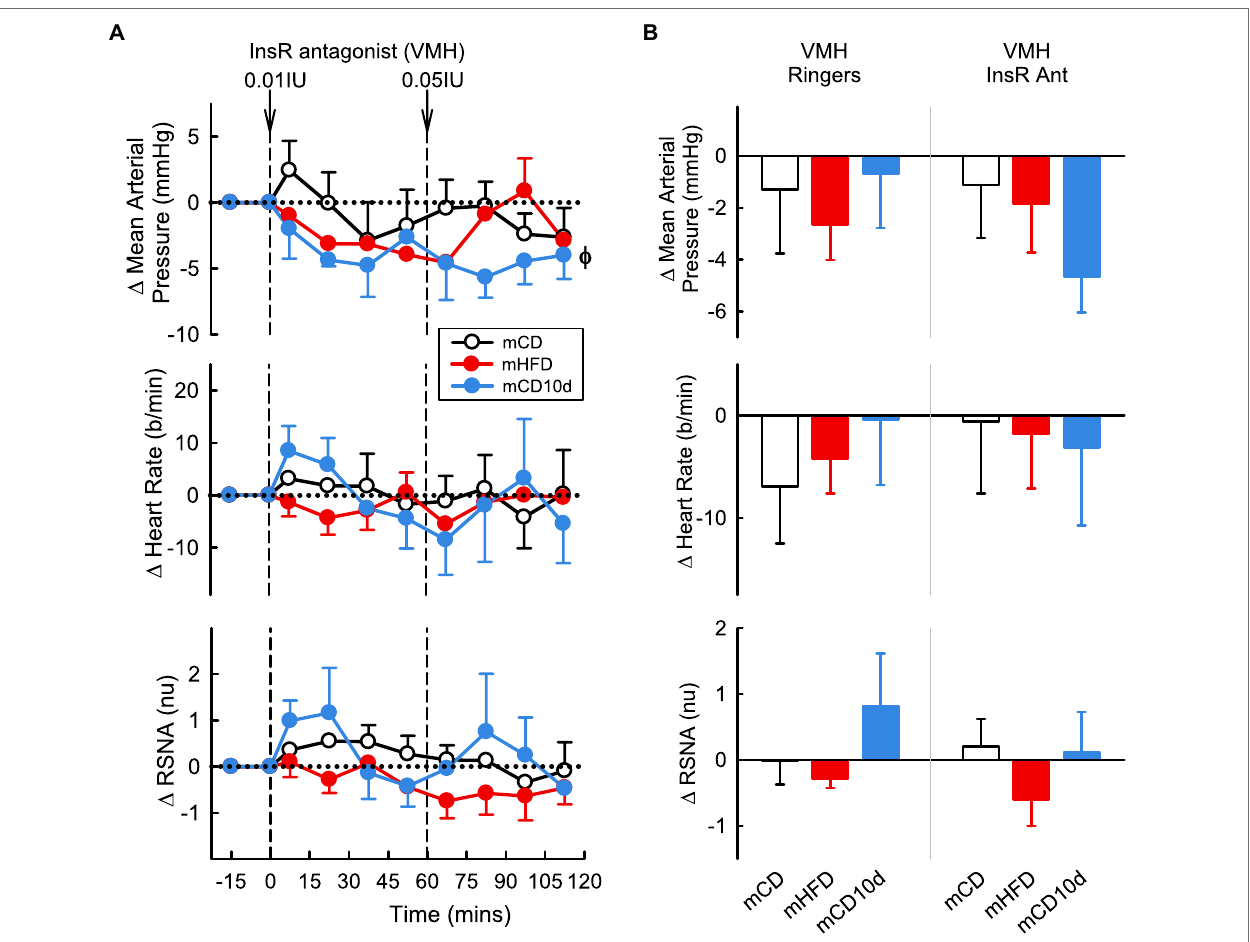
FIGURE 11 | Effects of InsR antagonist injected in the VMH. (A) Average changes in MAP, heart rate, and RSNA (normalized units) from control in each group after VMH injection of InsR antagonist (0.01, 0.05 IU, shown at dashed lines) in mCD (white, n = 7), mHFD (red, n = 5), and mCD10d (blue, n = 3) rabbits. Data are mean difference ± SED. ϕ p < 0.05 for average effect of InsR antagonist. (B) Changes from control after administration of vehicle Ringer’s and InsR antagonist, averaged over the second dose, given into the VMH in mCD, mHFD, and mCD10d rabbits. Data are mean difference ± SED from the control period of each treatment